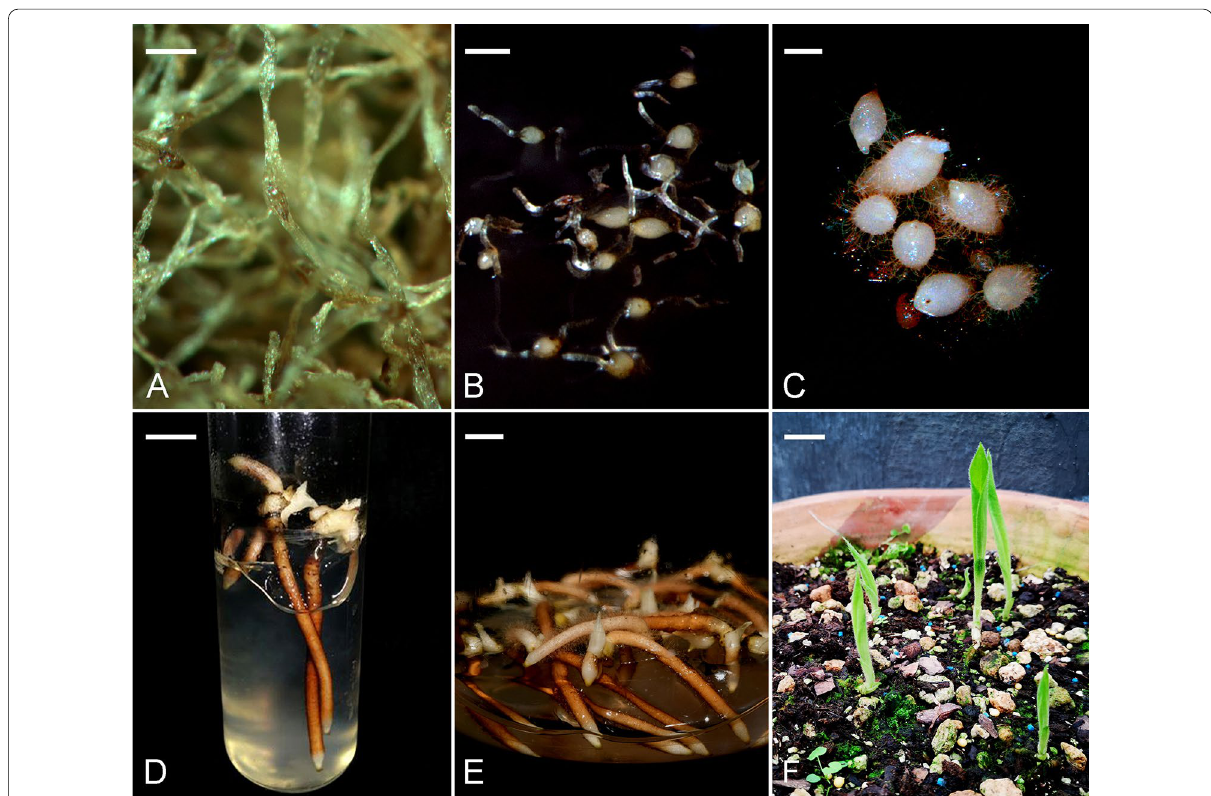
1 mm. B Swelling of the embryos results in seed = 2 mm. D Before shoot elongation, several = 7 mm. F =